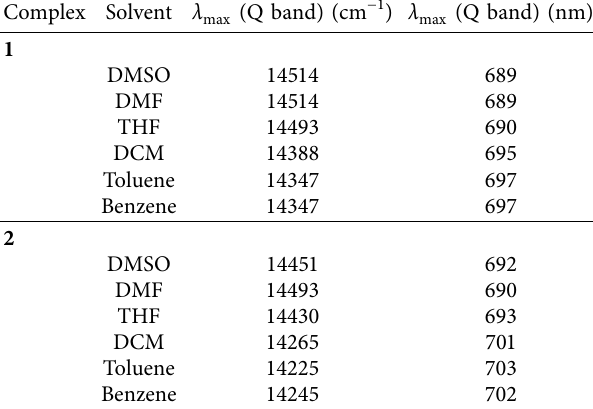
Table 1: Absorption maxima of complexes 1 and 2 in different solvents.